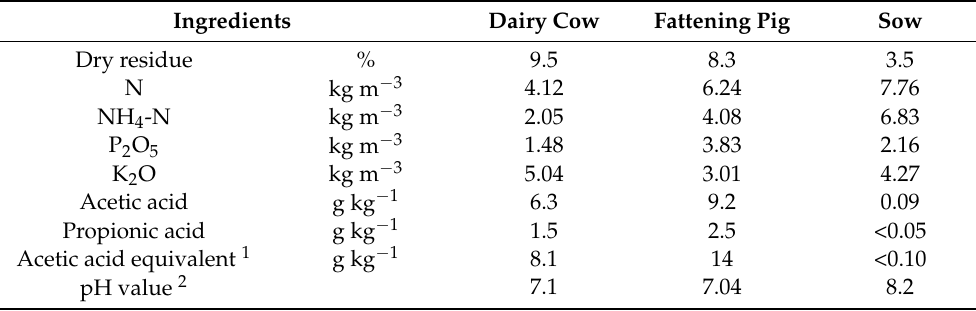
Table 2. Characteristics of dairy cow, fattening pig and sow slurry (fresh material) before acidification